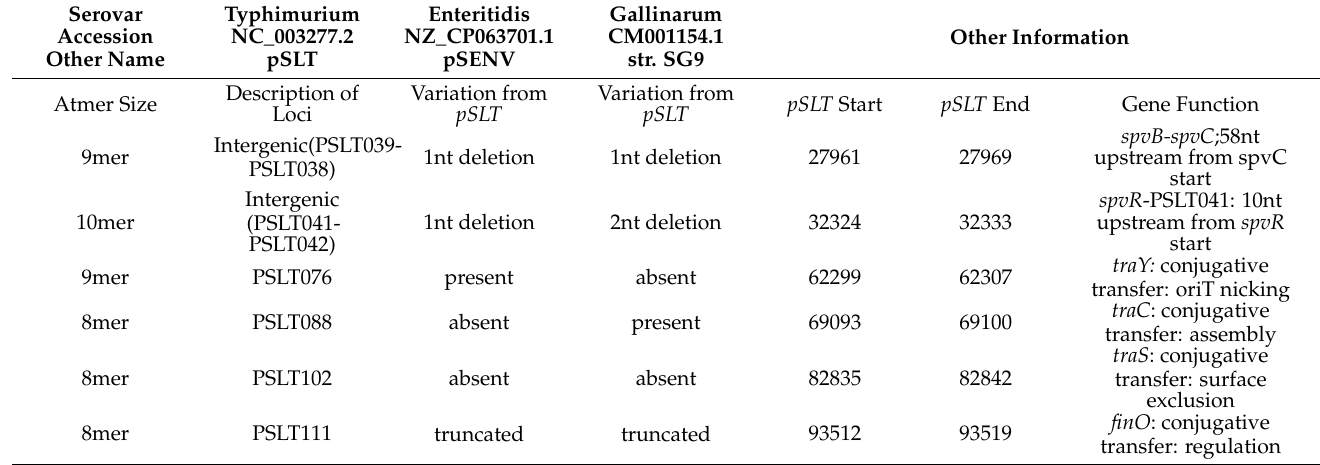
Table 3. AT 8+mer motif variation in 3 serotypes of Salmonella enterica subspecies I.